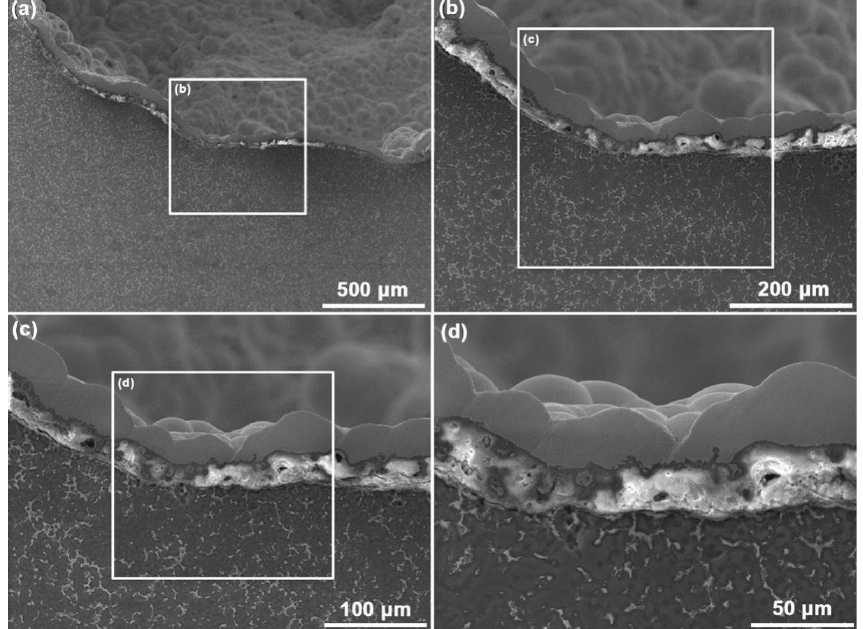
Figure 4. Microstructure on the cross-section of the AZ91D hybrid foams: ( a ) strut edge. ( b ) enlarged image in the box marked in ( a ) continuous coating. ( c ) enlarged image in the box marked in ( b ) that displaying structure of MAO coating. ( d ) enlarged image in the box marked in ( c ) that showing mechanical interlocking between MAO and EN coatings.